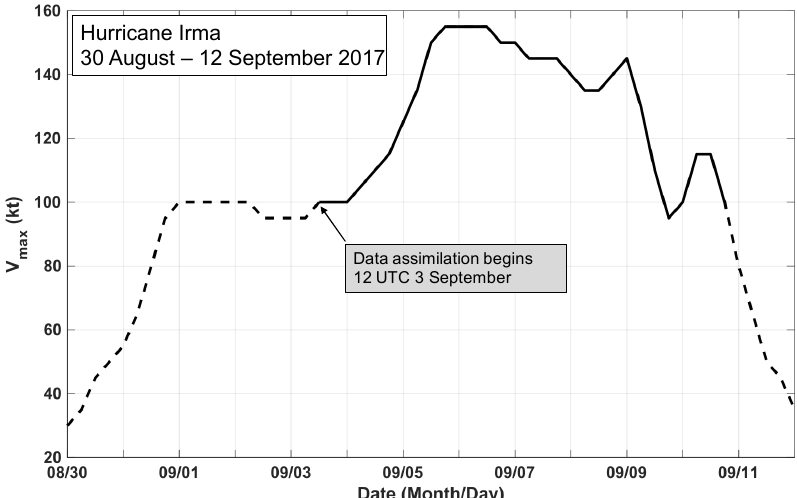
Figure 2. Intensity (maximum sustained winds, kt) time series of hurricane Irma (2017) from its formation west of the Cape Verde Islands on 30 August until its dissipation over the southeastern United States on 12 September. The dashed portions of the time series reflect those time periods for which cycling data assimilation was not performed.